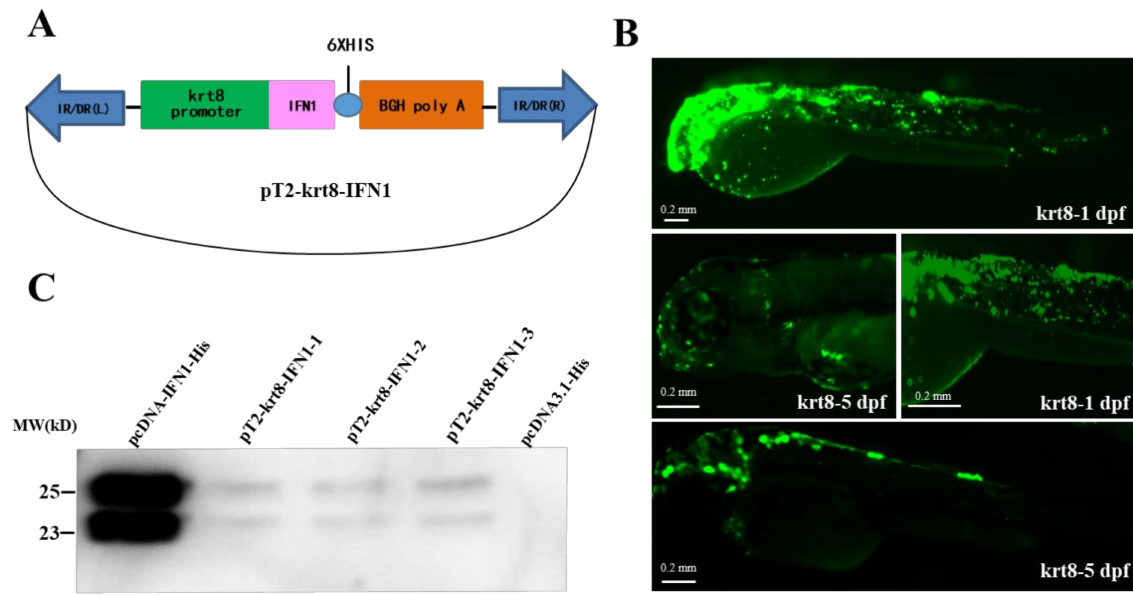
Figure 1. Construction of a transgenic vector. ( A ) Plasmid map of the transgenic vector containing a krt8 promoter, grass carp interferon (IFN1) cDNA and His-tag. ( B ) The expression of EGFP under fluorescence microscope. krt8-1dpf: One day after fertilization; krt8-5dpf: five days after fertilization. ( C ) Western blot analysis of IFN1 in 293T cells. Group pcDNA-IFN1-His: 293T cells were transfected with pcDNA-IFN1-His; pT2-krt8-IFN1-1, 2 and 3: 293T cells were transfected with pT2-krt8-IFN1; Group pcDNA3.1-His: 293T cells were transfected with